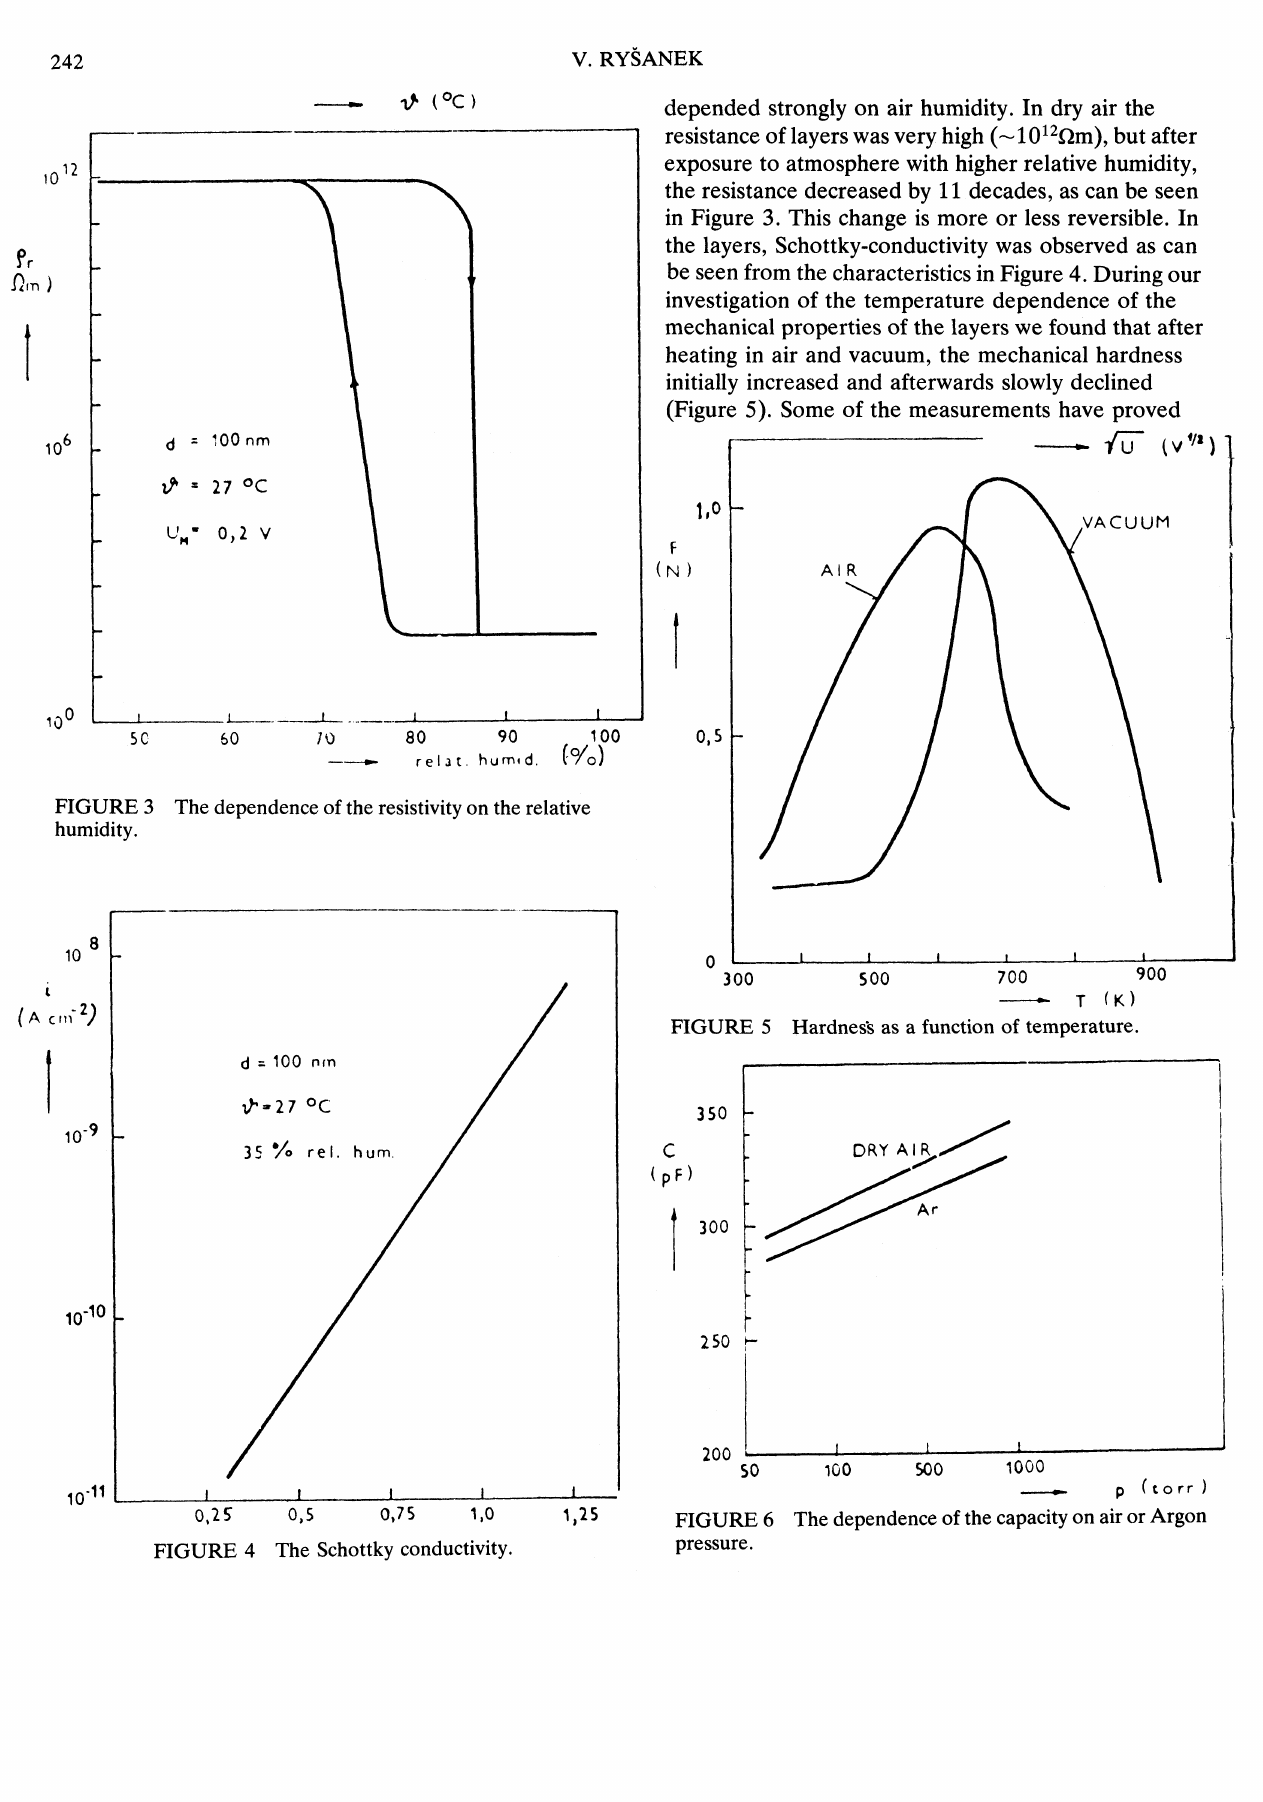
FIGURE 4 The Schottky conductivity.